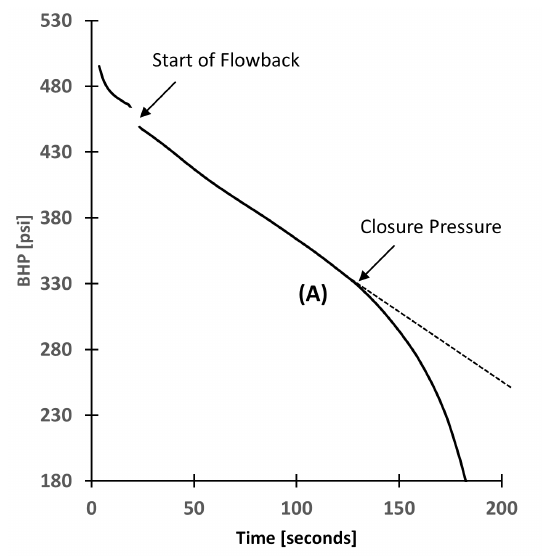
Figure 2. Cartesian plot shows flowback analysis [28].